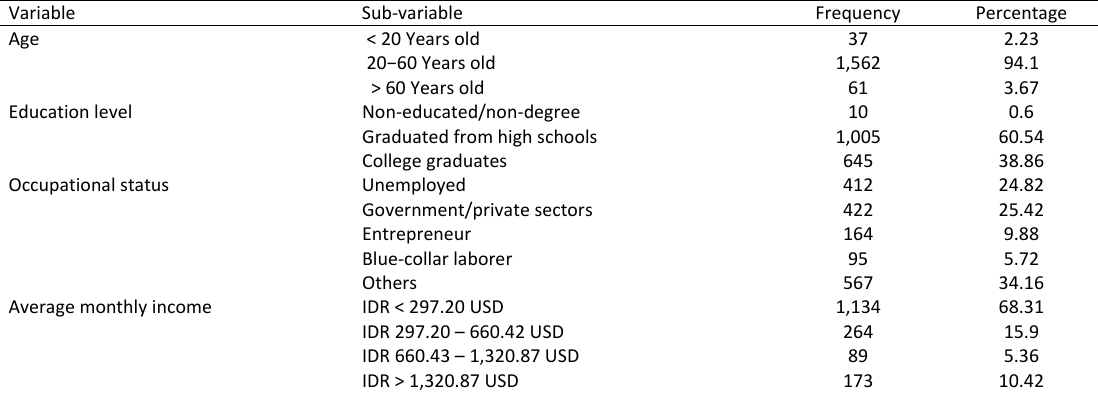
Table 1: Socioeconomic characteristics of respondents